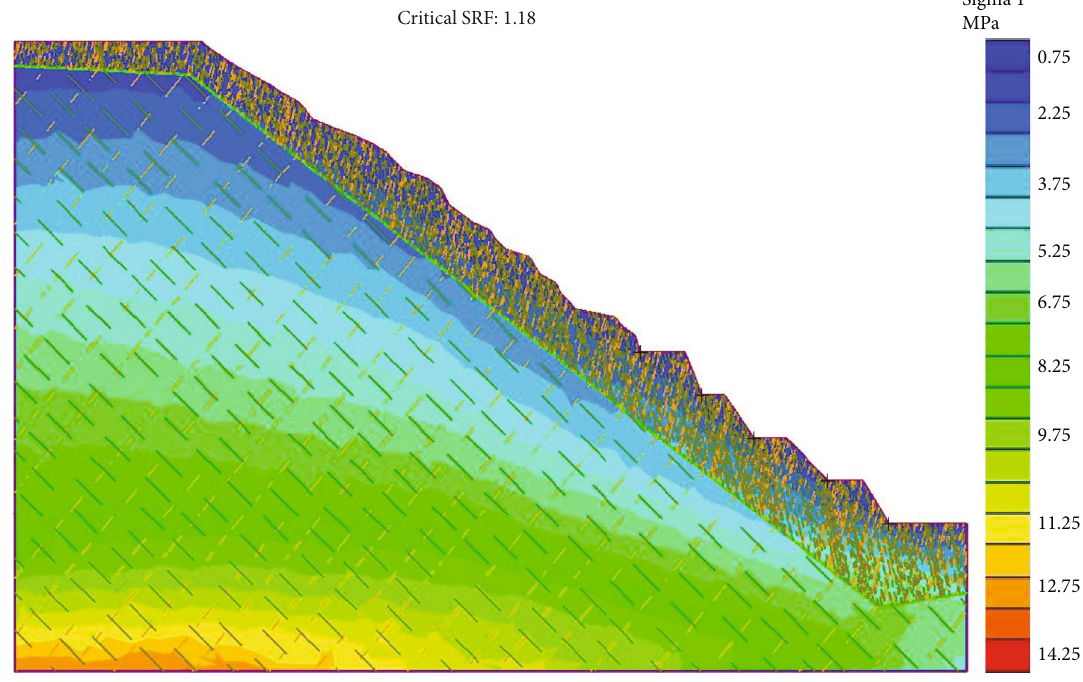
Figure 13: Cloud chart of maximum and minimum principal stress for di ff erent times of the freeze-thaw